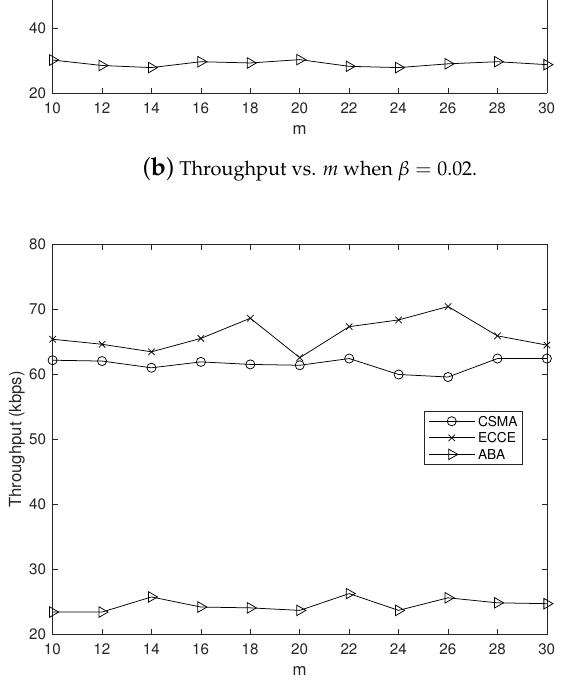
( c ) Throughput vs. m when β = 0.04. Figure 5. The impact of m on throughput when α =